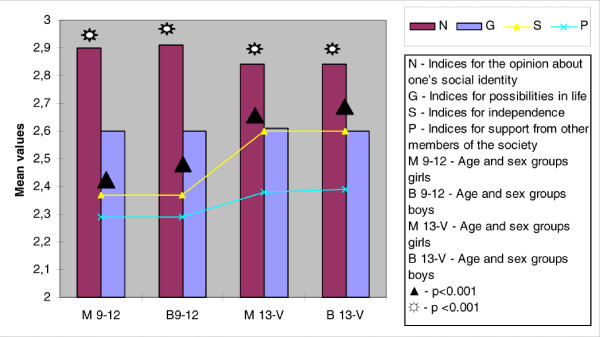
The self-awareness index of the emotional component of schoolchildren with disabilities by age and sex. The relationship between the values of the self-awareness index (opinion about one's social identity, possibilities in life, independence, support from other members of the society) of disabled schoolchildren's attitudes, and their age and sex (girls, boys).